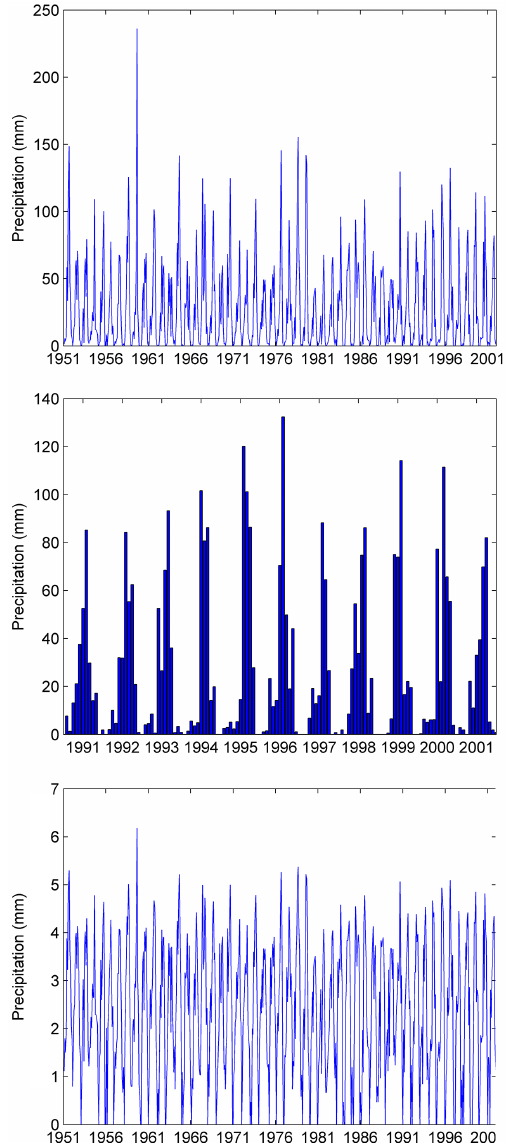
Figure 3. Monthly precipitation at the Lanzhou precipitation sta- tion. Upper panel: observation (1951–2001); middle panel: ob- servation (1991–2000); lower panel: after power transformation (1951–2001).